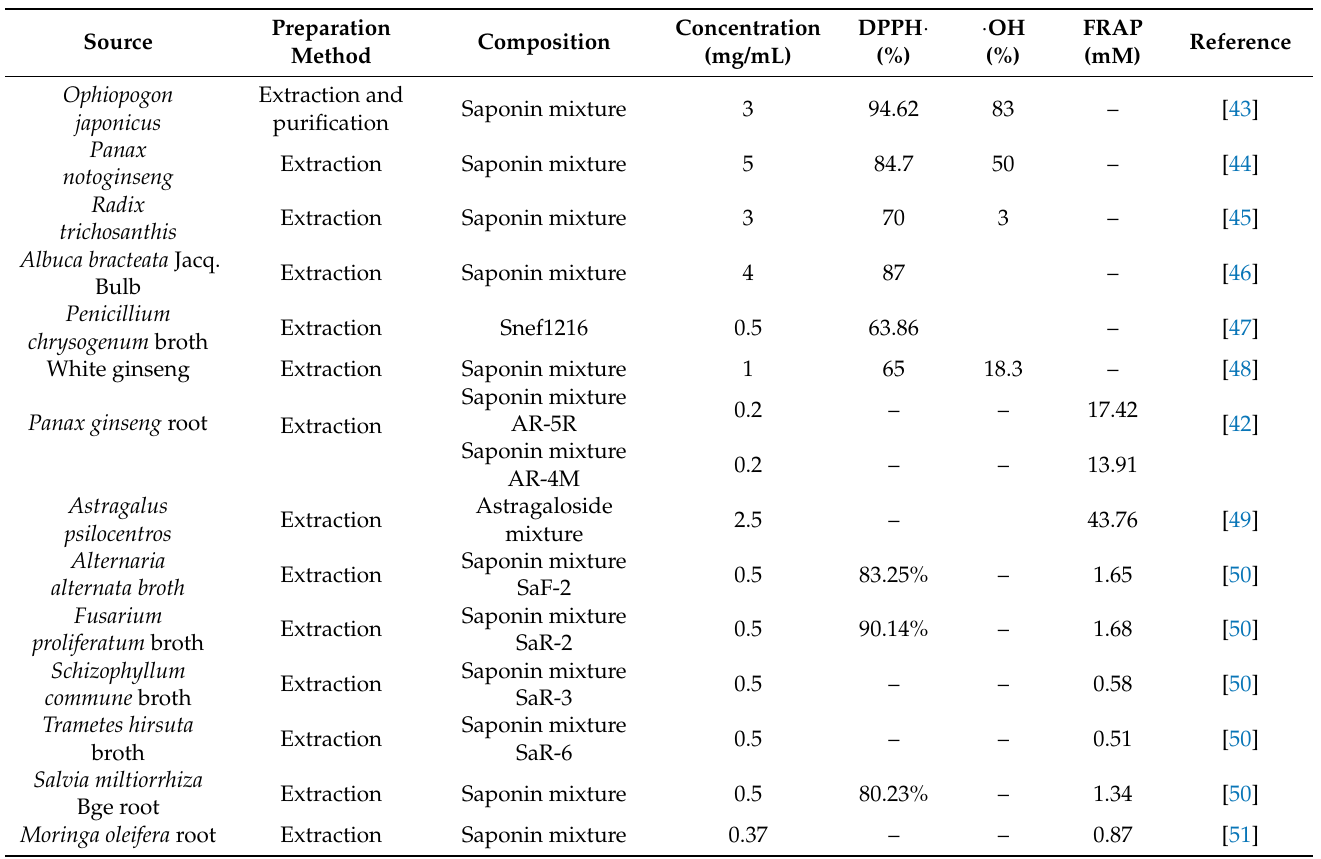
350 nm, Figure S2: QTOF-MS/MS analysis for the crude saponin extract, Figure S3: The structure and MS/MS spectrum of the new substance in crude saponin extract with rutin addition, Figure S4: The structure and MS/MS spectrum of the possible saponin in crude saponin extract with/without rutin addition (Retention time = 4.29